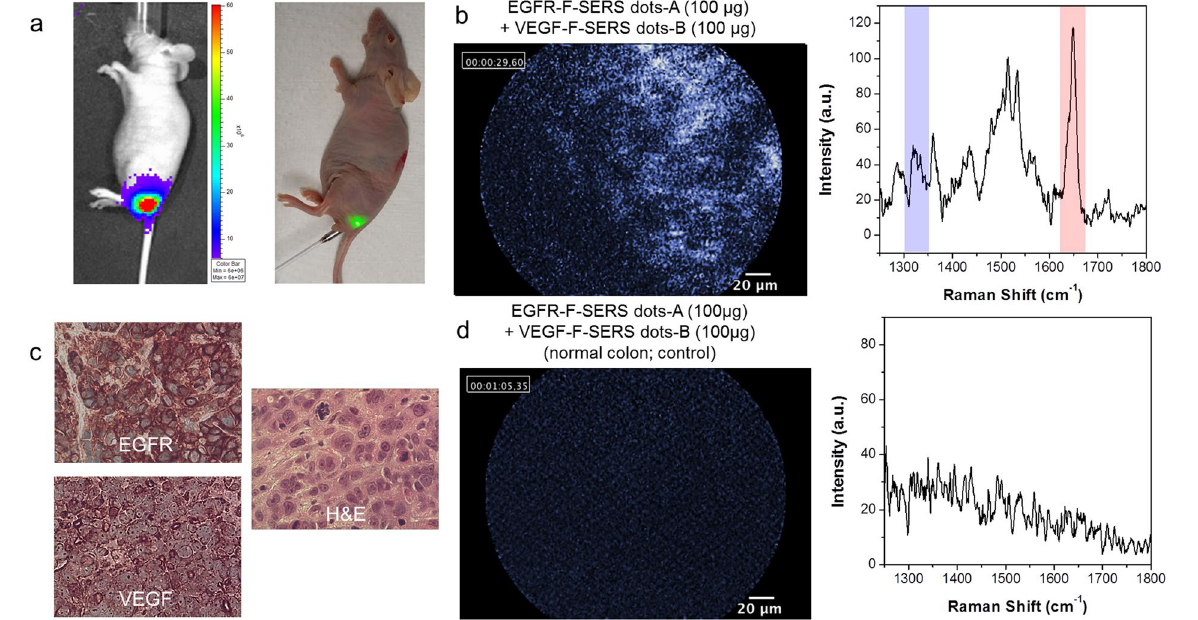
Figure 5. Evaluation of FRES in a real-time endoscopic system. ( a ) Orthotopic CRC xenograft modeling. One week after injecting 1 × 10 7 HT29-effluc cells, bioluminescence imaging (left) showed moderate-to-high activity in the colorectal area of mice (lateral view; n = 20). The FRES imaging method used in a real-time endoscopic system is shown (right). ( b ) Mice with CRC (two weeks after injecting 1 × 10 7 of HT29-effluc cells) were investigated in a real-time endoscopic study of FRES. After spraying 100 µ g each of EGFR-F-SERS-A and VEGF-F-SERS-B dots, fluorescence signals were found as well as two corresponding Raman signals [RITC (-A) and FITC (-B)]. ( c ) Tumors were excised, fixed, and sectioned. EGFR and VEGF positivity was identified by immunohistochemistry (IHC), and tumor cell infiltration was observed by hematoxylin and eosin (H&E) staining. ( d ) After spraying 100 µ g each of EGFR-F-SERS-A and VEGF-F-SERS-B dots on normal colons (control), no fluorescence or Raman signals were